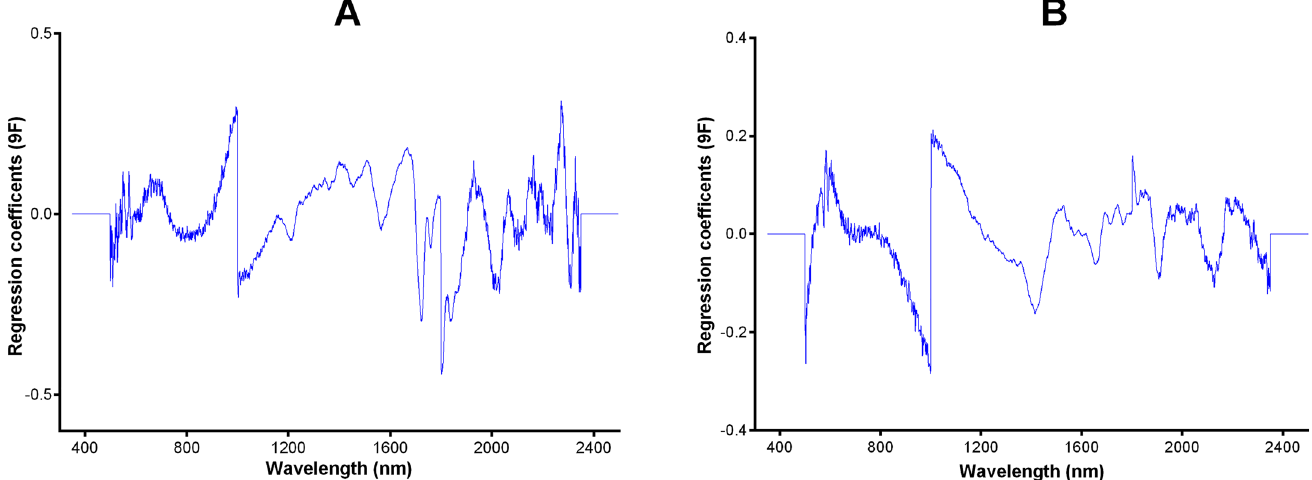
Fig 2. Regression coefficient plots used to predict the presence or absence of infection. They are based on 9 PLS regression factors. The plots show peaks that influenced the differentiation of female w MelPop from female w Mel (panel A) and female w Mel from female wild type Ae . aegypti (panel